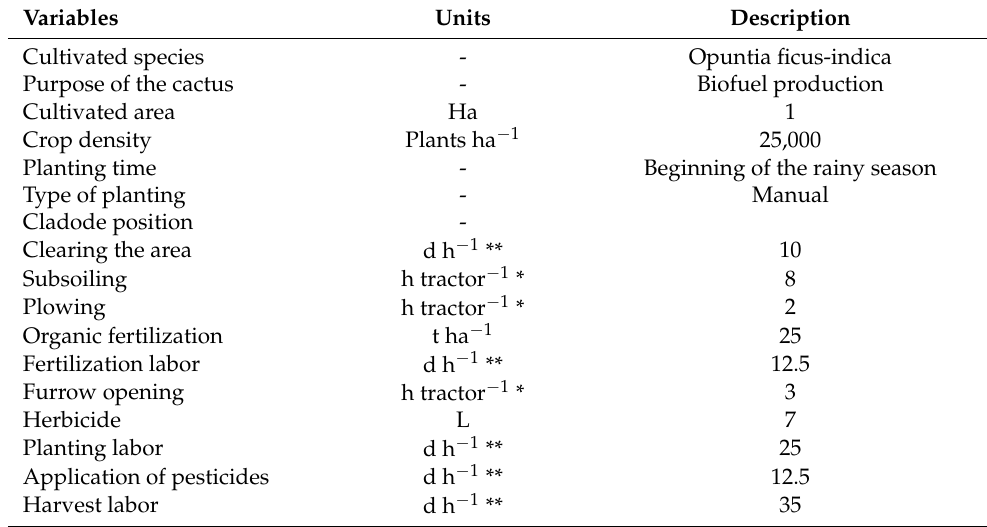
Table 1. Characteristics of the cultivation system in the Brazilian Northeast region.